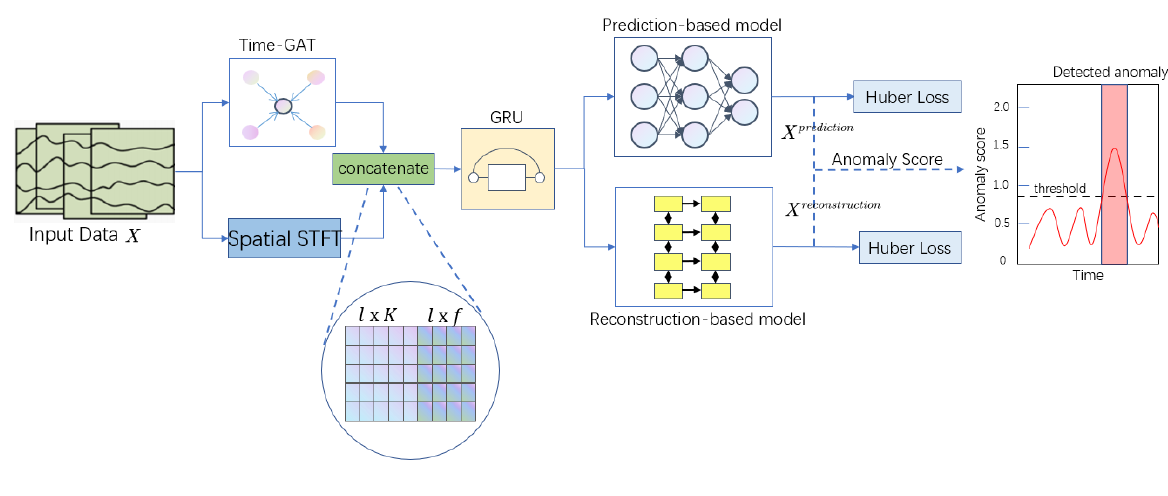
Figure 1. The overall architecture of our proposed